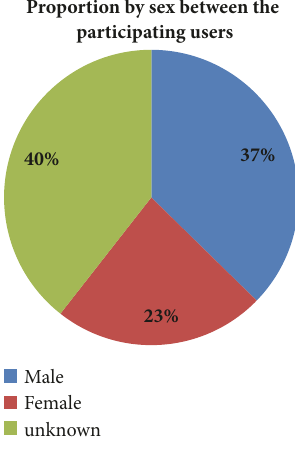
Figure 5: Proportion by sex.